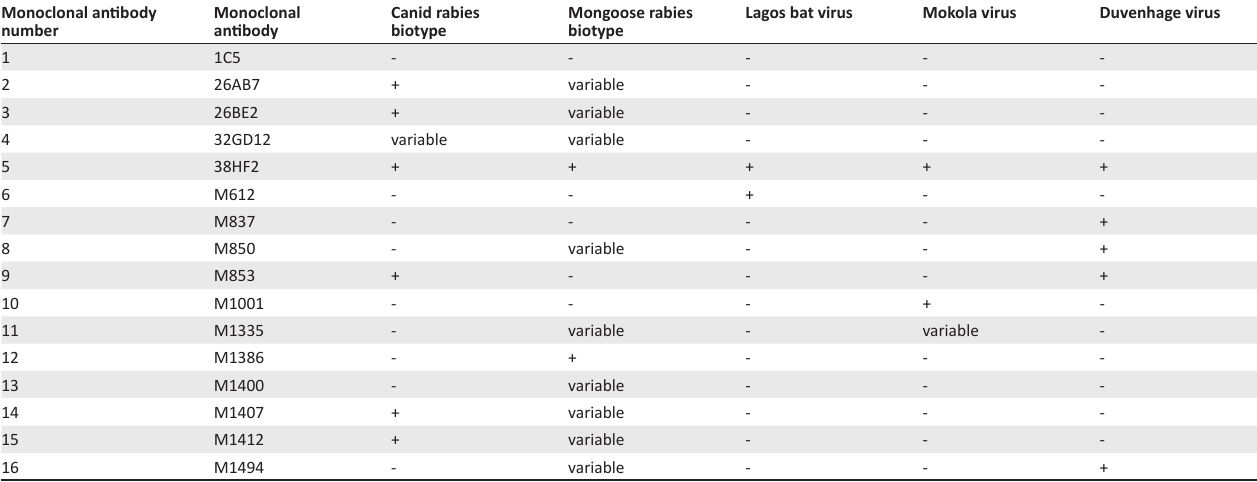
TABLE 1: Typical reactivity patterns of African lyssaviruses against a panel of 16 monoclonal antibodies. Monoclonal antibody